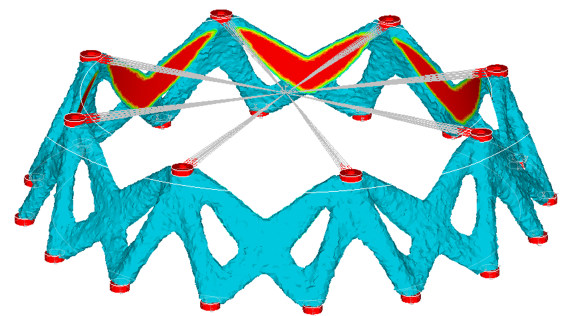
Figure 7. Topology optimization results of the support structure.